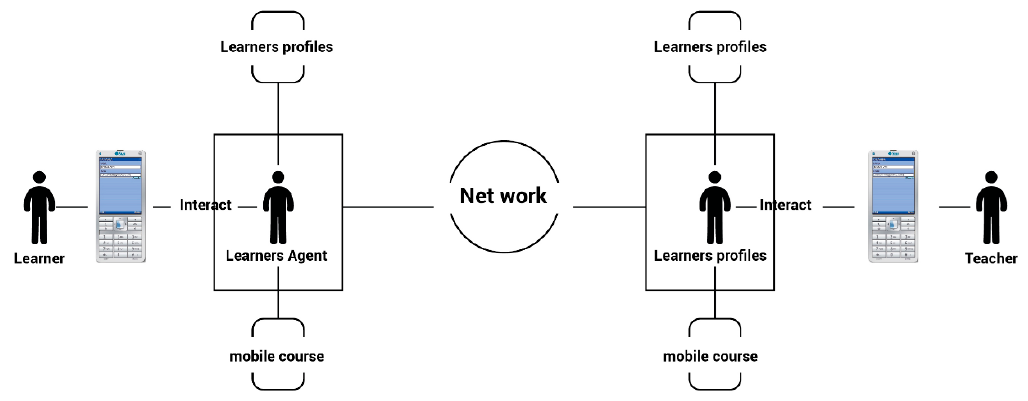
Figure 4. M-learning environment based on agents.